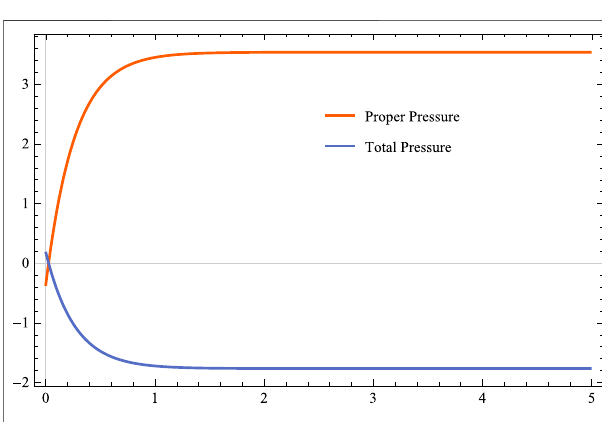
FIGURE 2 | Variation of total pressure ( (cid:2) p ) and proper pressure ( p ) vs . time ( t ).